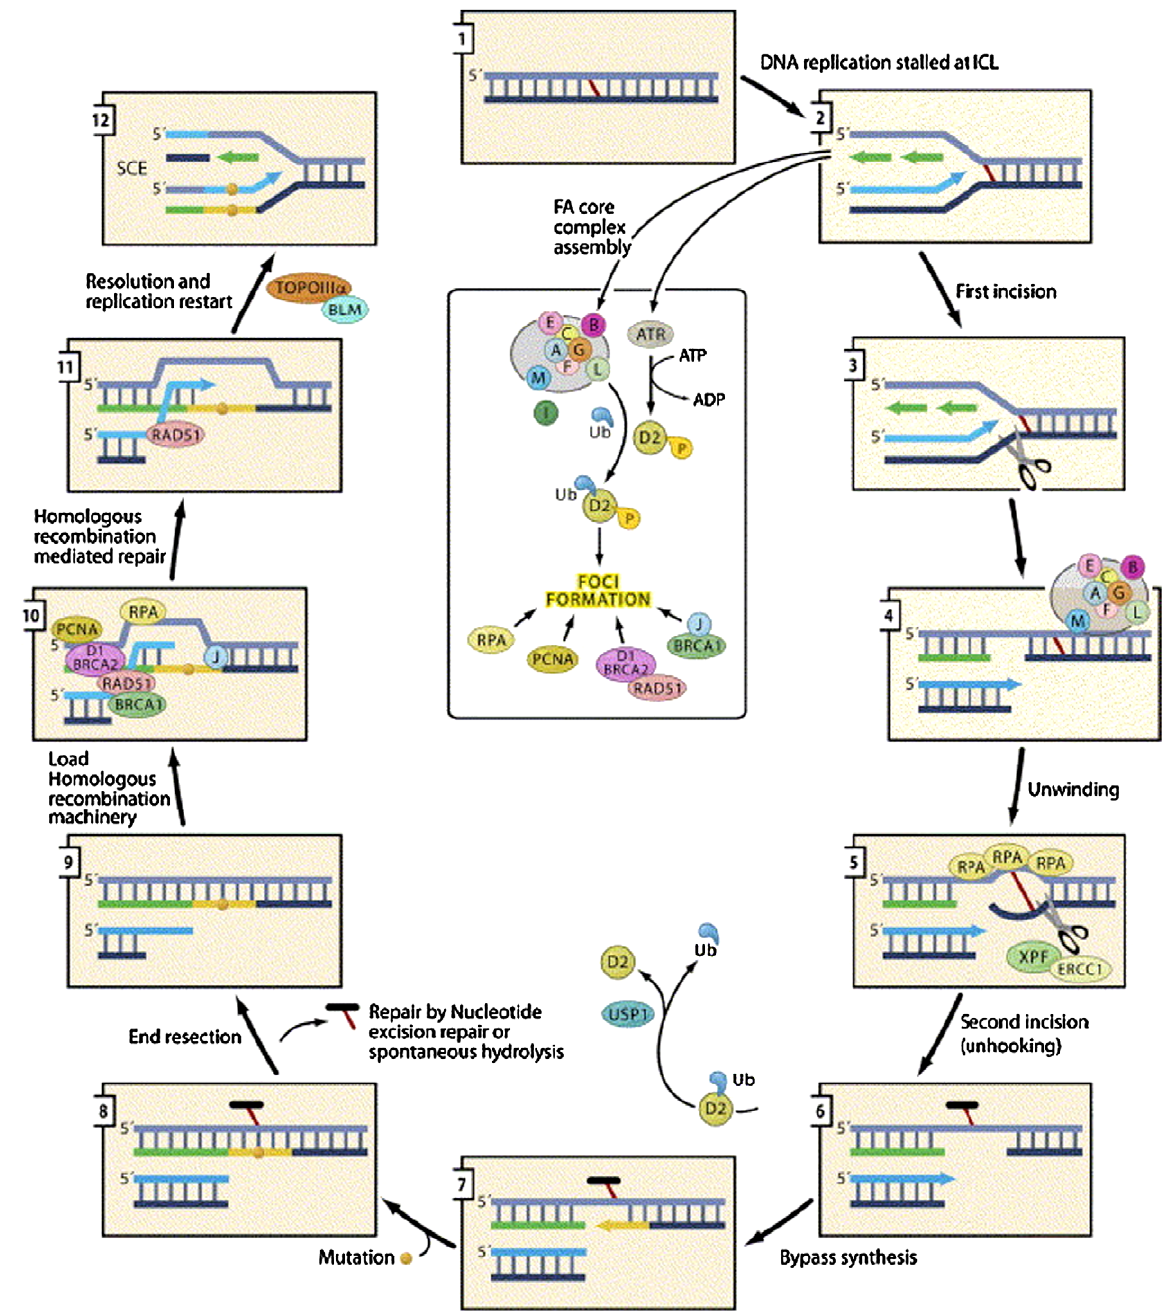
Fig. 7. Resolution of a DNA cross-link during DNA replication. When a DNA cross-link is encountered during replication, the replication fork will stall (1–2). One of the DNA strands is cut, which results in a double stranded break (DSB) and a strand with a ssDNA gap. This DSB can be visualized by the γ -H2AX protein that is shown to bind to these lesions. To resolve the cross-link, ERCC1 and XPF make another incision opposite of the ssDNA gap. This allows the cross-link to be removed from one strand. The ssDNA gap can now be fixed by translesion synthesis (TLS) over the damaged site at the complementary strand (3–7). Excision repair and subsequent normal DNA synthesis ensures repair of the complementary DNA strand (8–9). Homologous repair is needed to repair the DSB and to re-initiate replication (10–12). (Figure reproduced with permission from Cell (Niedernhofer et al.) [106]. c (cid:2) 2005,